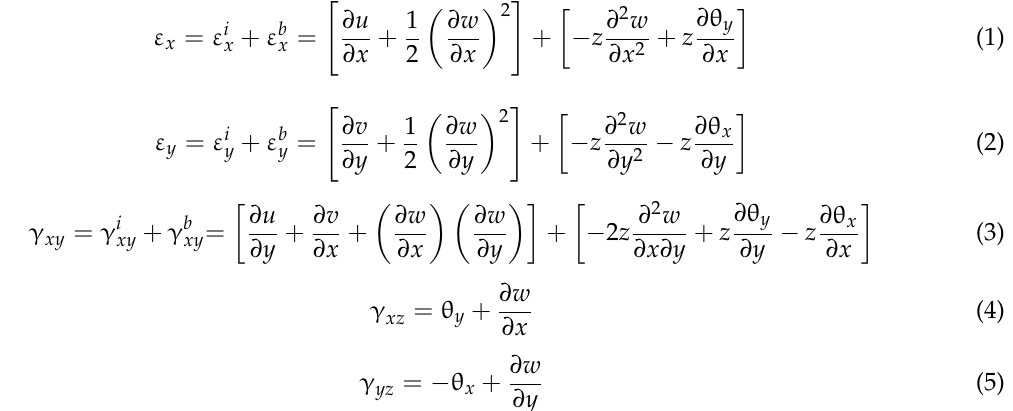
Figure 2. Finite model of 5A06 aluminum alloy structure ( a ) FE model. ( b ) Butt weld FE model,